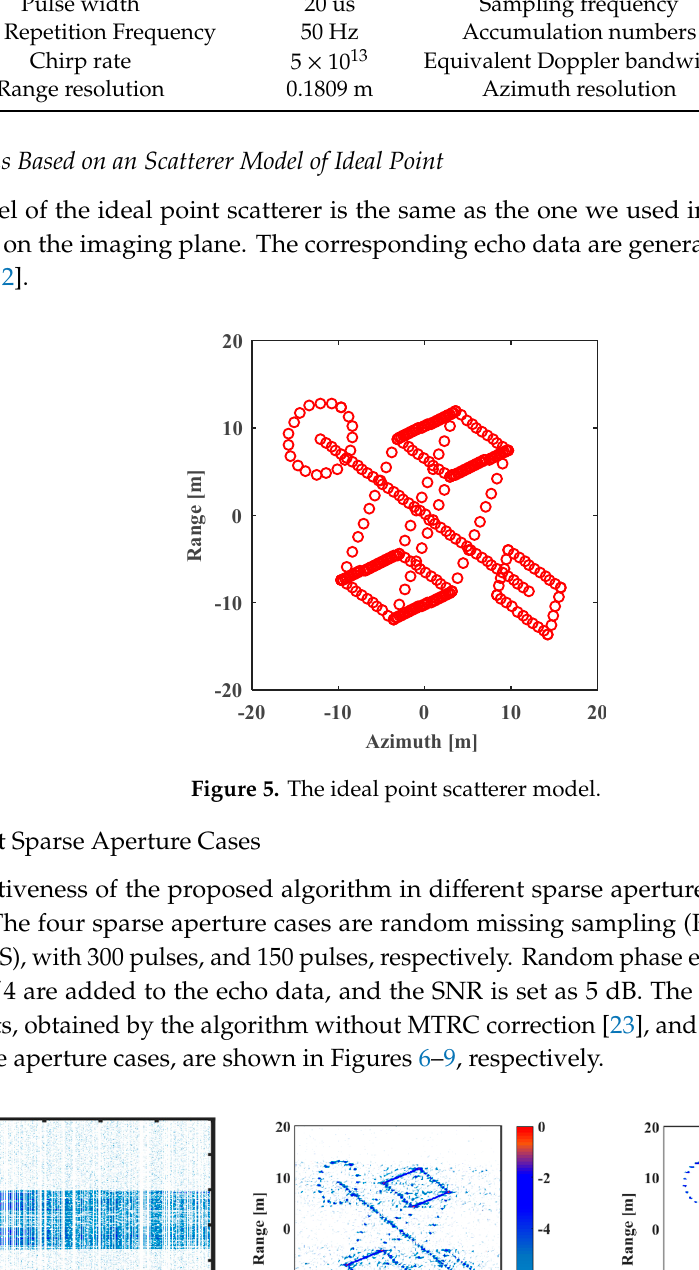
( c ) Figure 7. Range profiles and imaging results with RMS of 150 pulses: ( a ) Range profiles; ( b ) Imaging result of algorithm in [23]; ( c ) Imaging result of the proposed algorithm. ( a ) ( c ) Figure 8. Range profiles and imaging results with GMS of 300 pulses: ( a ) Range profiles; ( b ) Imaging result of algorithm in [23]; ( c ) Imaging result of the proposed algorithm. ( a ) ( c ) Figure 9. Range profiles and imaging results with GMS of 150 pulses: ( a ) Range profiles; ( b ) Imaging result of algorithm in [23]; ( c ) Imaging result of the proposed algorithm. 4.2.2. Different SNRs